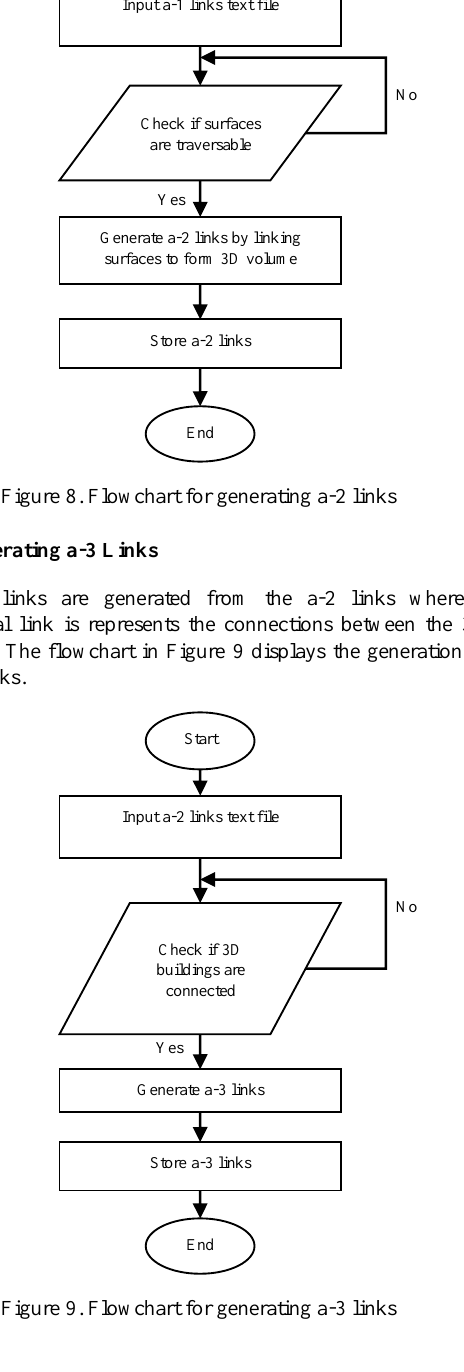
Figure 7. Flowchart for generating a-1 links